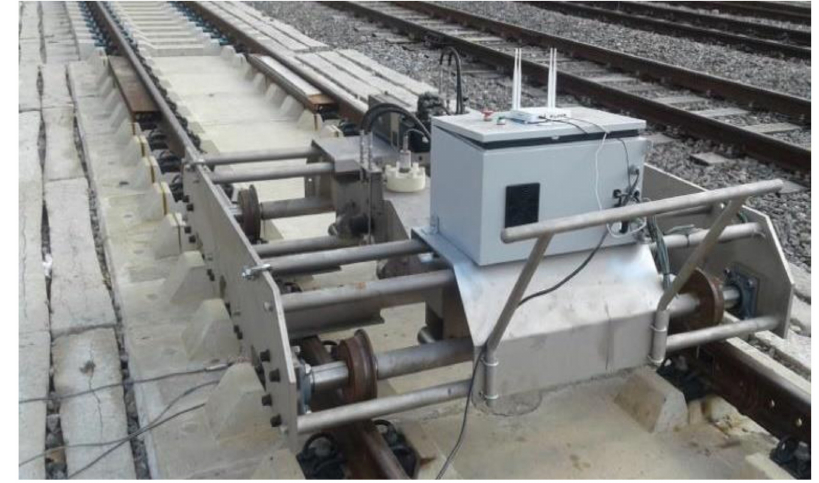
Figure 15. Photograph of the TSS tester.